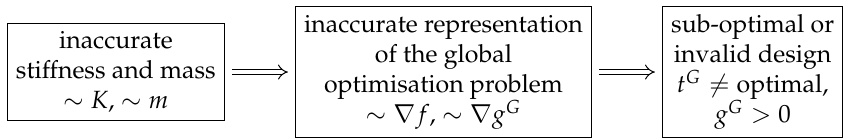
Figure 17. Inaccurate representation of the global optimisation problem.